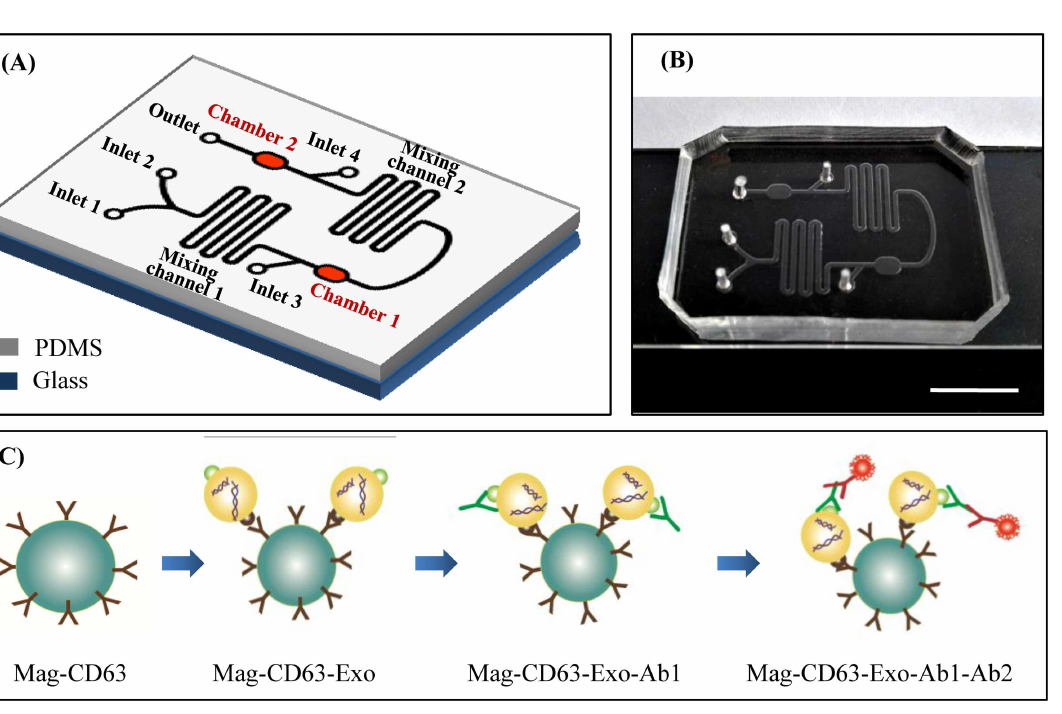
Fig 1. Chip design and principle for exosome capture and detection. (A) Schematic representation of the microfluidic chip. (B) Image of the chip. The scale bar represents 1 cm. (C) Workflow for the immunomagnetic capture and detectionof